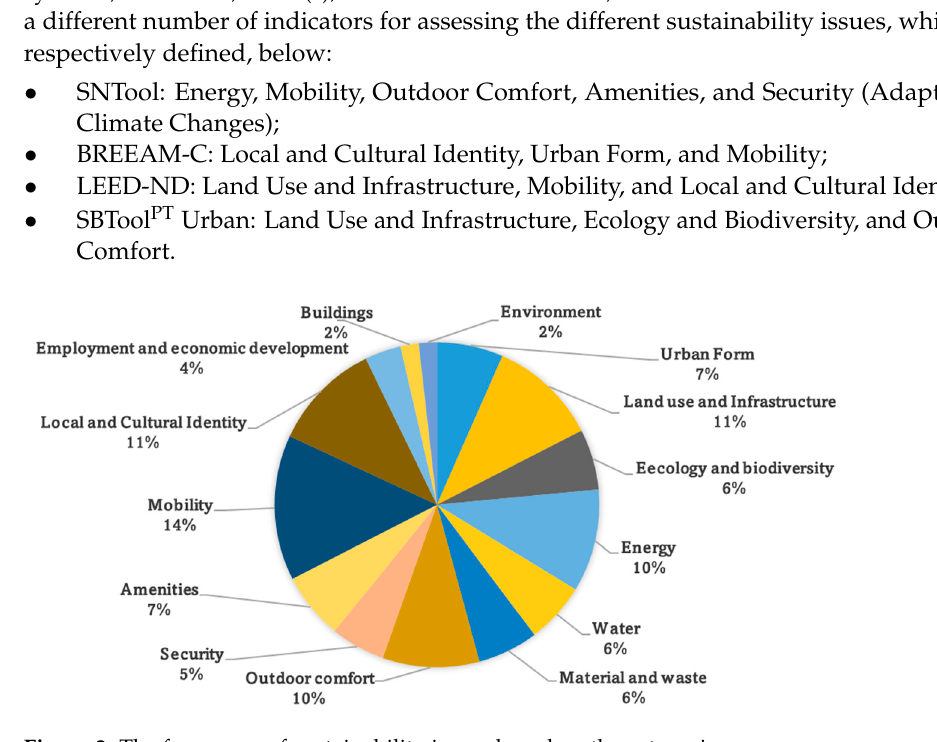
Figure 2. The frequency of sustainability issues based on the